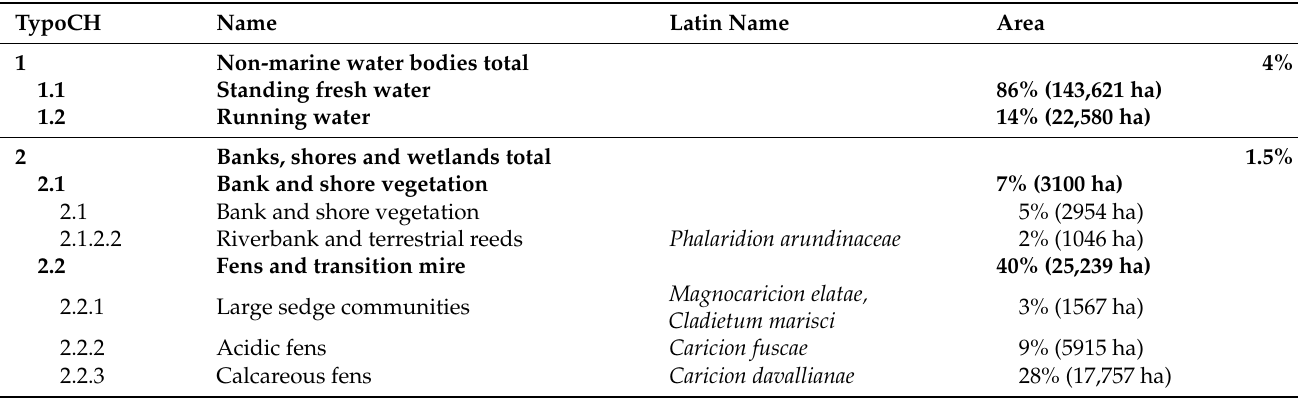
Table 4. TypoCH habitat types and groups mapped for the Habitat Map of Switzerland. The Latin name of the habitat type according to Delarze et al. [21] is given where appropriate. The ‘Area’ column shows the percentage of the entire area of Switzerland covered by each of the 9 habitat classes (highlighted in grey). In addition, for each type or group, the percentage cover of their respective class as well as their total area in hectares is